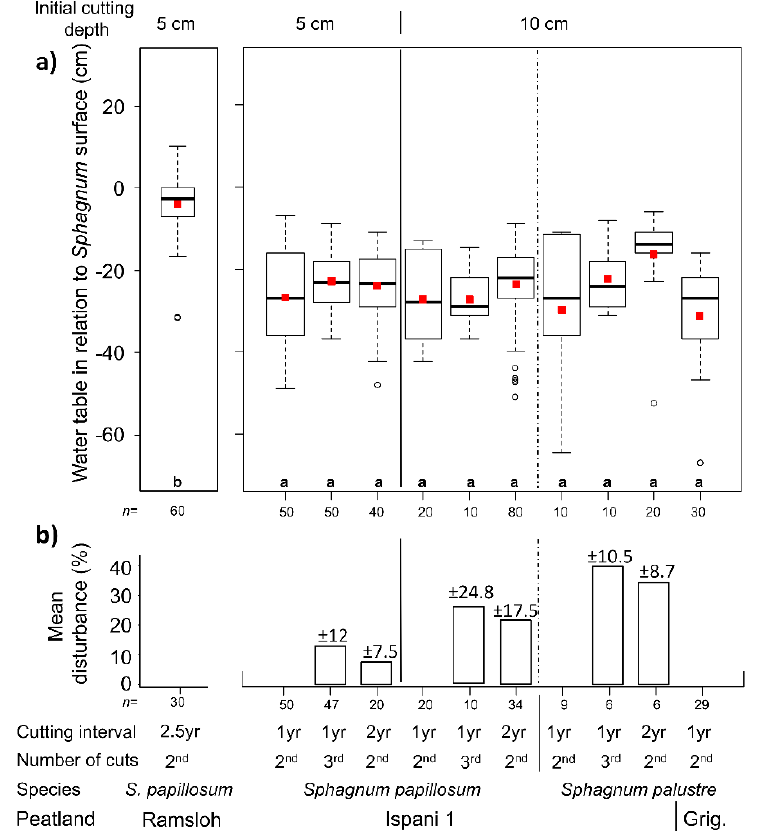
Figure 6. a) Position of water table relative to Sphagnum surface (= 0 cm), and b) mean disturbance (standard deviation written above each bar), for treatments with different combinations of initial cutting depth (5, 10 cm), cutting interval (1, 2 years) and number of cuts (second or third cut) at the Ramsloh Sphagnum farming field in Germany (Sep 2008–Mar 2011), and at Ispani 1 (Apr 2007–Mar 2009) and Grigoleti (Apr 2008–Mar 2009) in Georgia. n = number of measurements. For an explanation of the ‘box and whisker’ graph format, see the caption to Figure 5. Statistically significant differences in a) are indicated by different letters ( P ≤